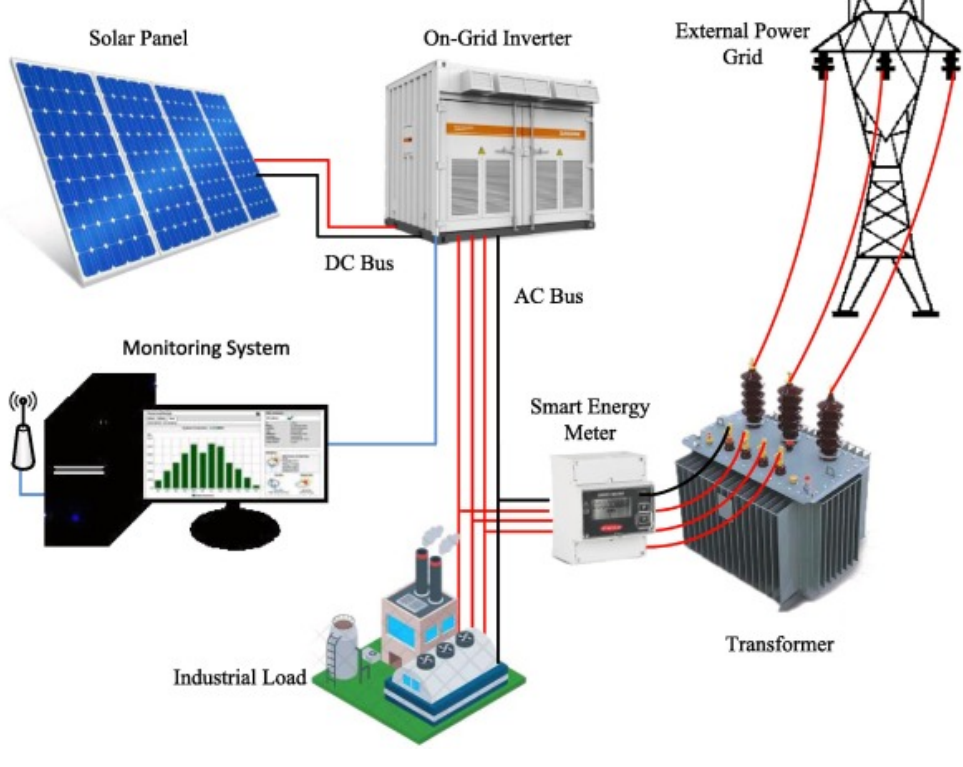
Figure 1. PV plant schematic diagram [8].